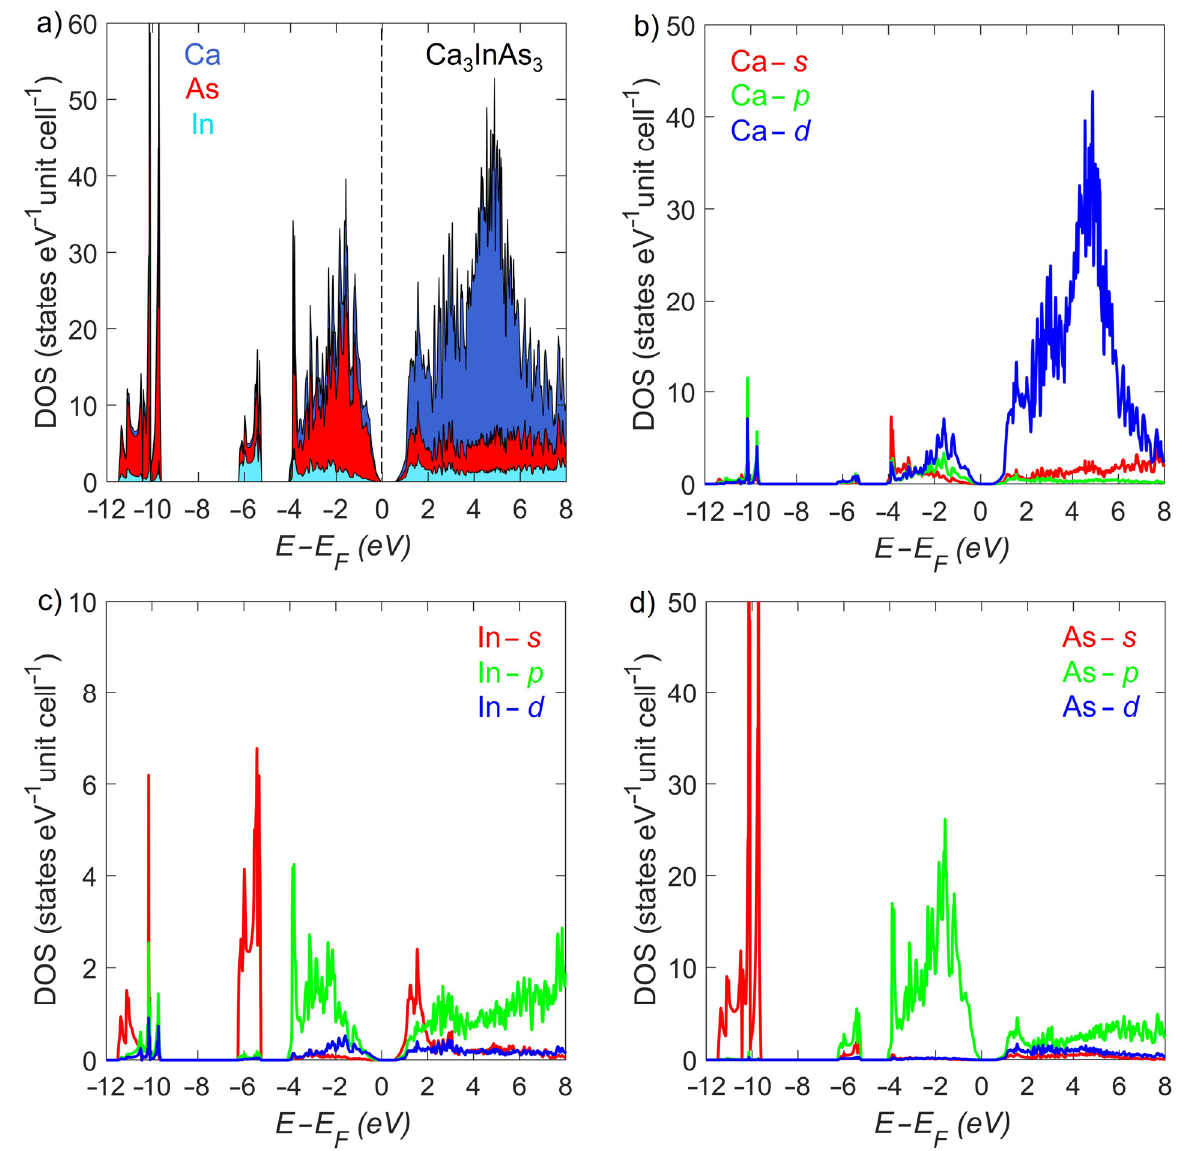
Figure 2. ( a ) The stacked atom-projected electronic density of states (DOS) for Ca 3 InAs 3 . The Fermi level is taken as a reference at 0 eV and represented with a dashed line. A bandgap of 0.46 eV can be observed. ( b ) Calculated partial DOS of different orbitals of for Ca. ( c ) Calculated partial DOS of different orbitals of for In. ( d ) Calculated partial DOS of different orbitals of for As.